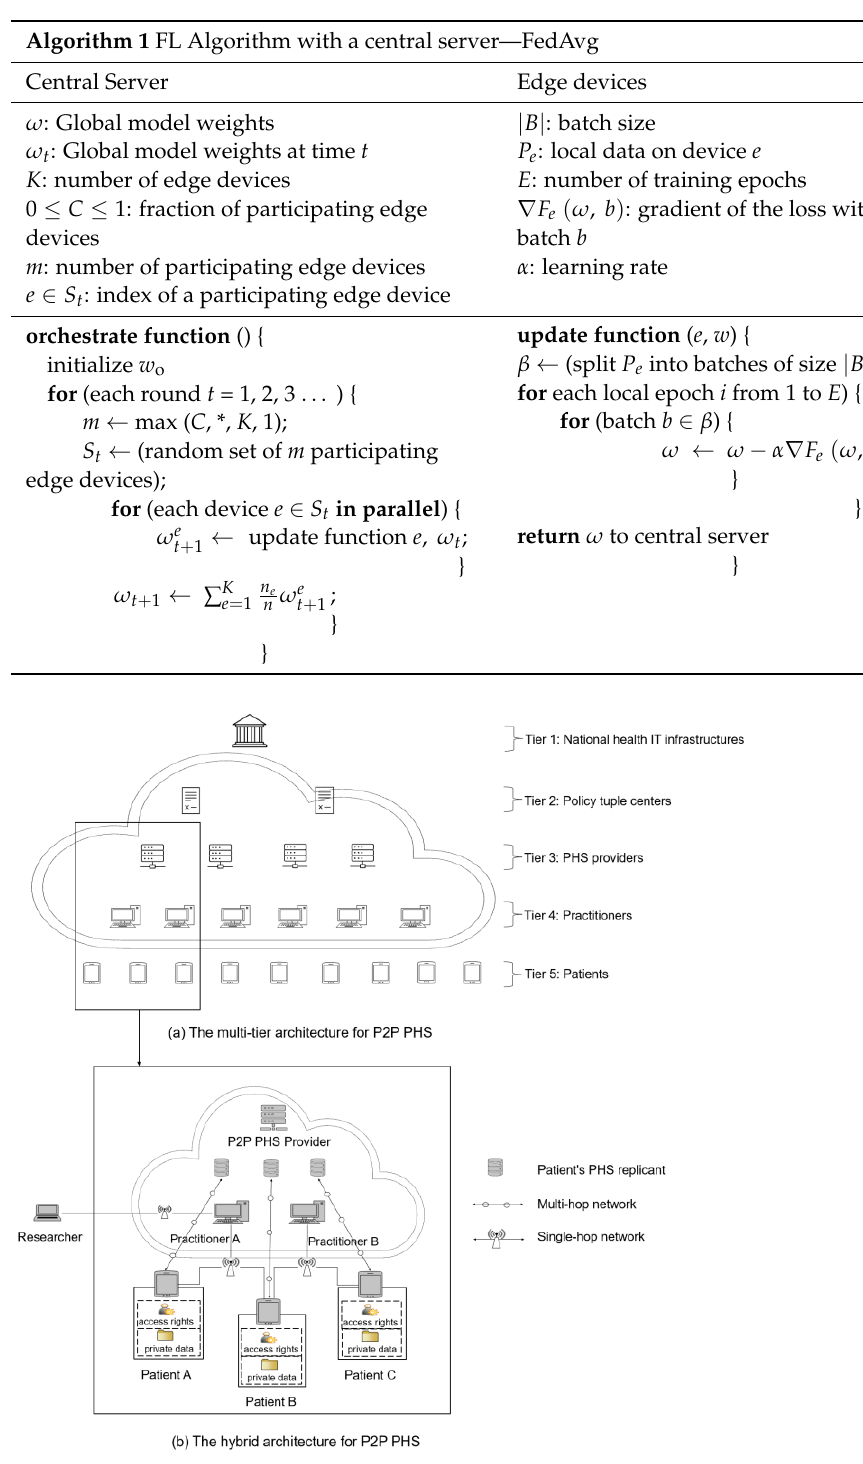
Figure 1. Peer-to-peer (P2P) high-level architecture for patient-centered health care information systems (PHSs) [1].